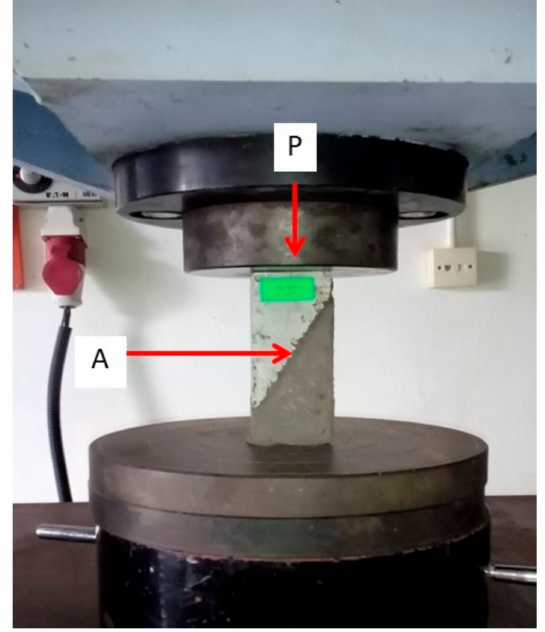
Figure 5. Experimental setup for the slant shear